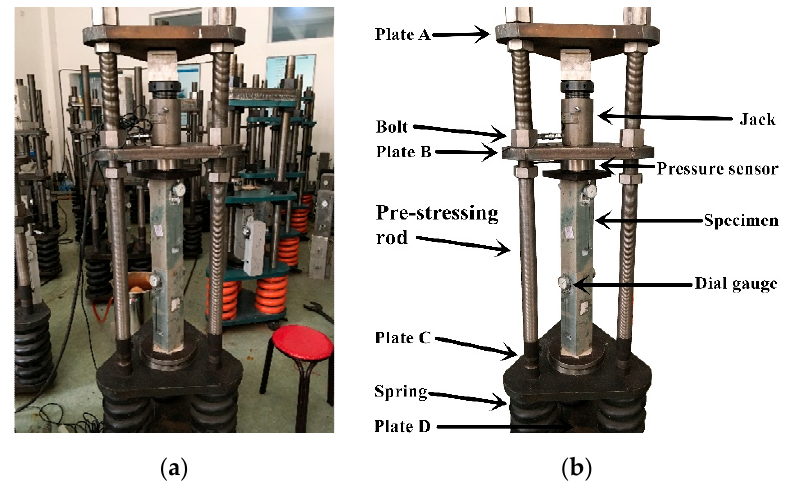
Figure 3. Self-resisting loading frame. ( a ) creep laboratory; ( b ) part name of the frame.